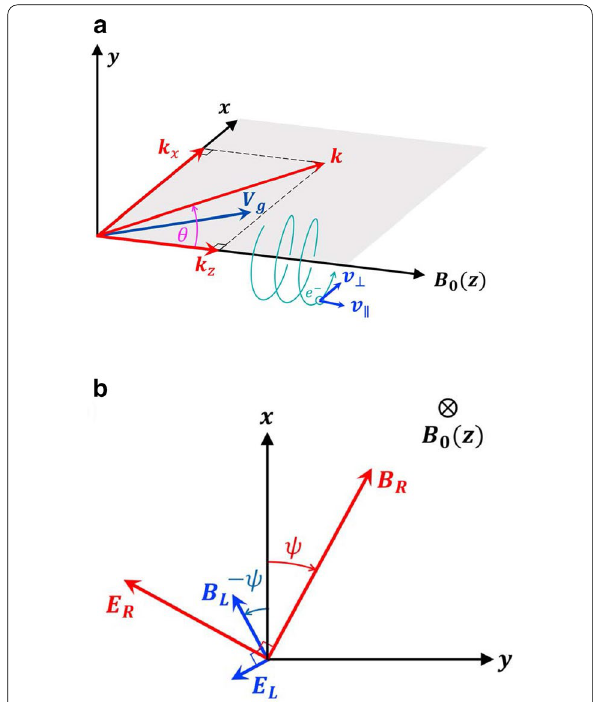
Fig. 12 Vector relations of oblique whistler-mode wave. a Configuration of vectors of the oblique whistler mode waves interacting with a resonant electron. b Wave vectors of right-hand circularly polarized wave (in red) and left-hand circularly polarized wave (in blue) in a plane perpendicular to the background magnetic field (after Omura et al. (2019))